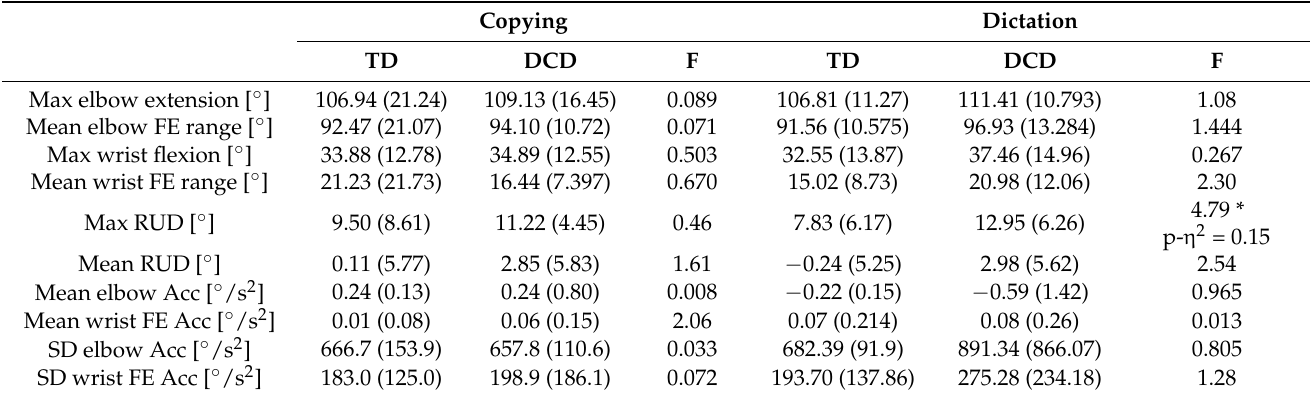
Table 4. Kinematics of the two handwriting tasks: copying and dictation. Mean and standard devia- tion in parentheses (RUD of the wrist were very small, making the 2nd derivative, i.e., accelerations, too noisy, and therefore unreliable, and are thus not reported).